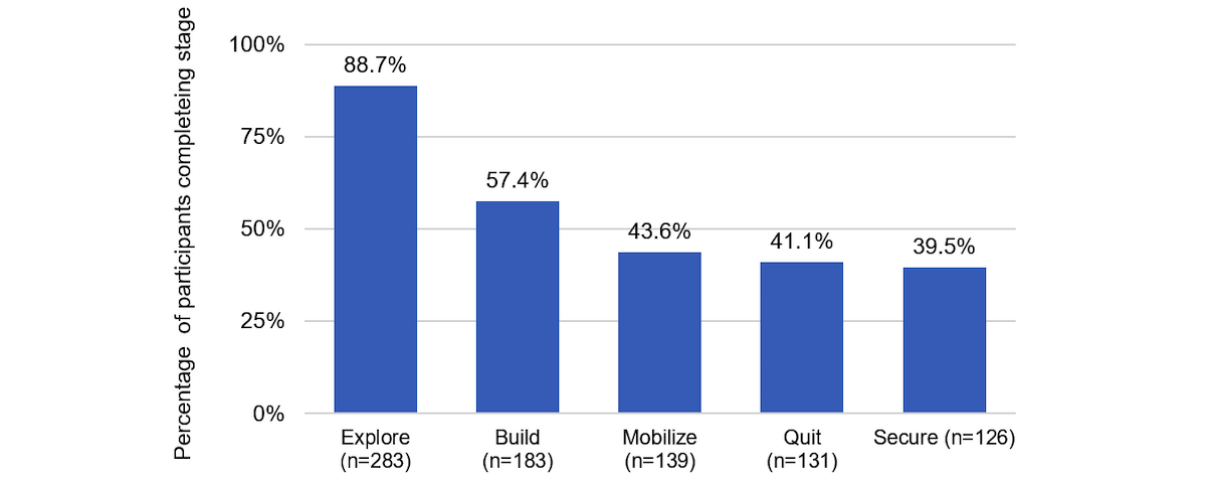
Figure 4. Proportion of participants who completed each Pivot stage, by those who onboarded